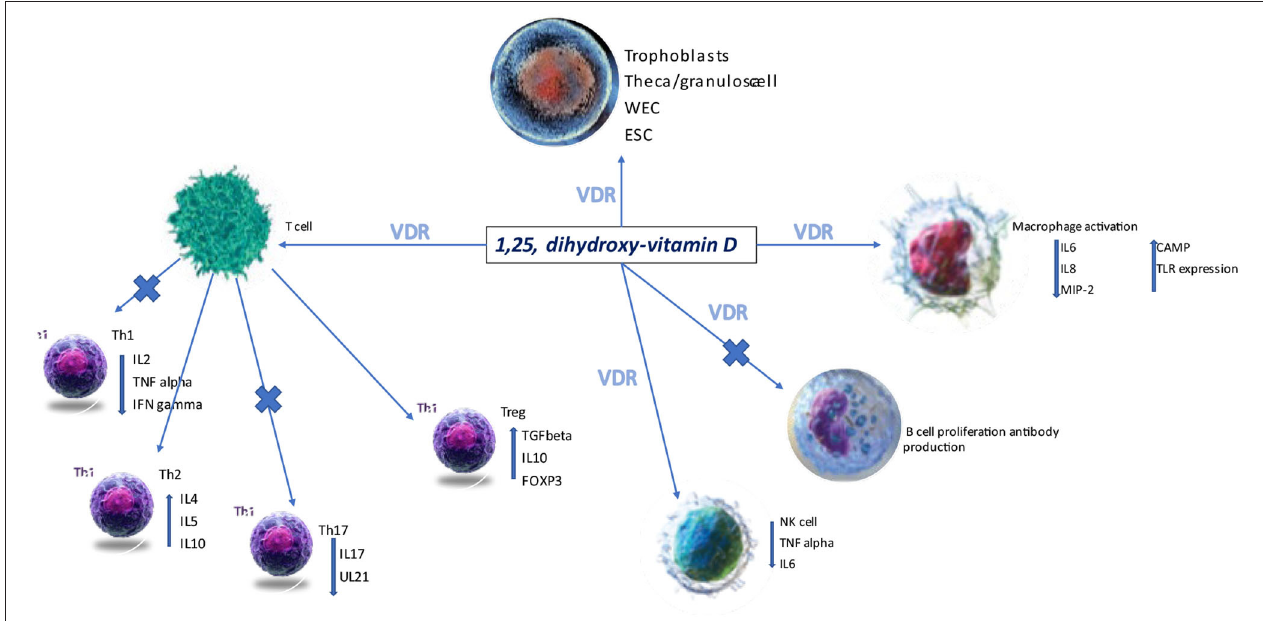
FIGURE 1 | VDR, vitamin D receptor; ESC, endometrial stem cells; NK, natural killer cells; Th, T helper; WEC, whole endometrium cells